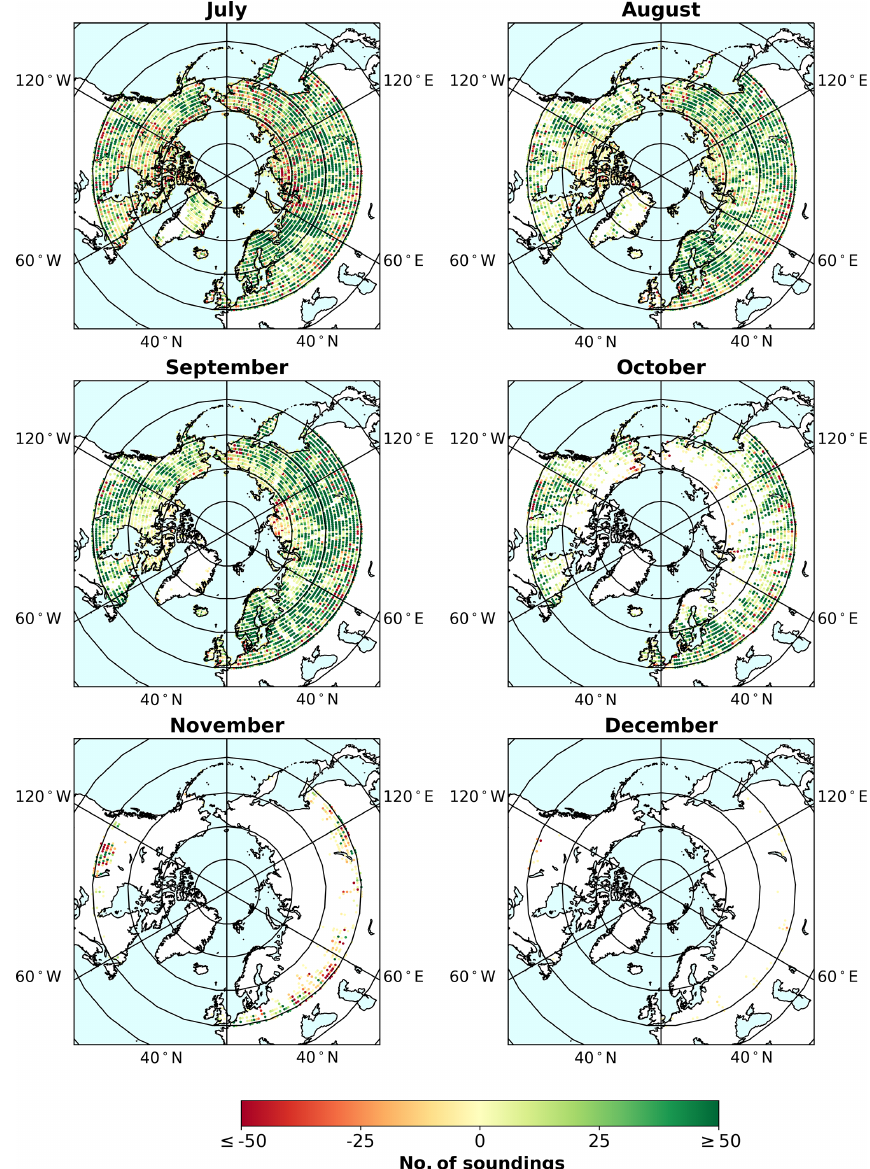
Figure 6. Maps of differences between the number of soundings passed by boreal QC and the number of soundings passed by B9 QC in each 1 ◦ latitude by 1 ◦ longitude grid cell in each month (July to December; summing all years from 2014 to